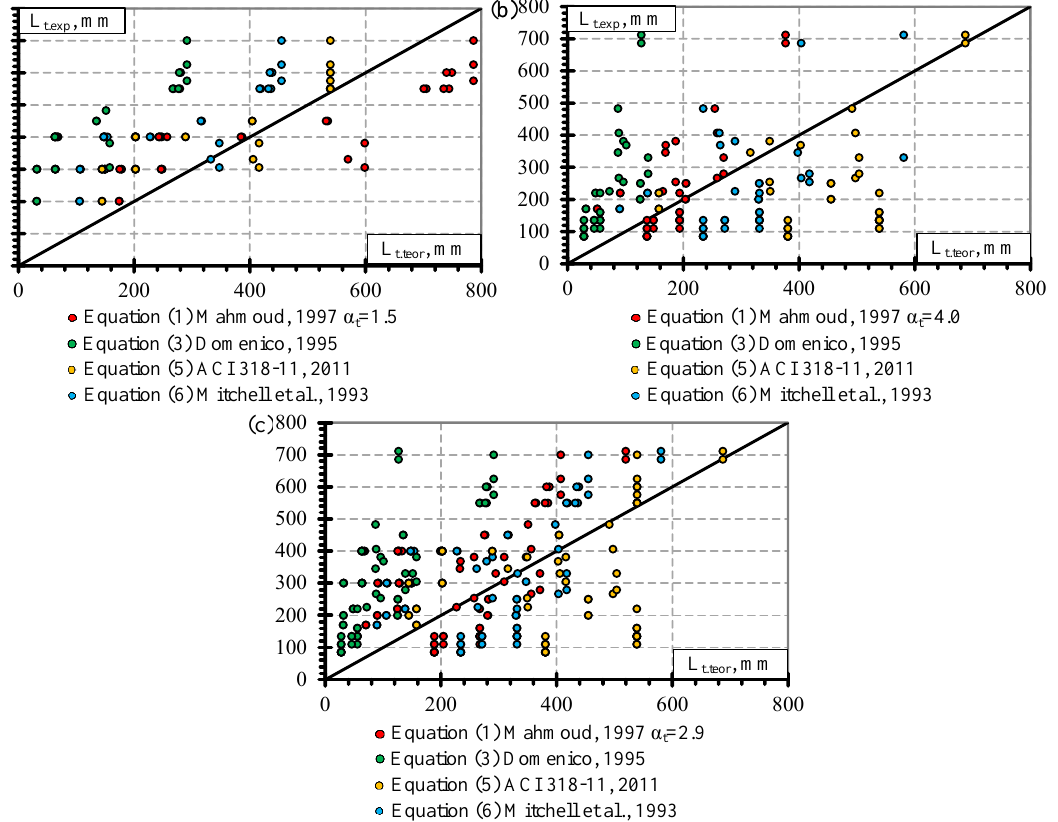
Figure 10. Relationship between the experimental and theoretical transfer lengths of AFRP rein- forcement with different surface conditions: ( a ) smooth braided, ( b ) sanded and rough, ( c ) both (all results)